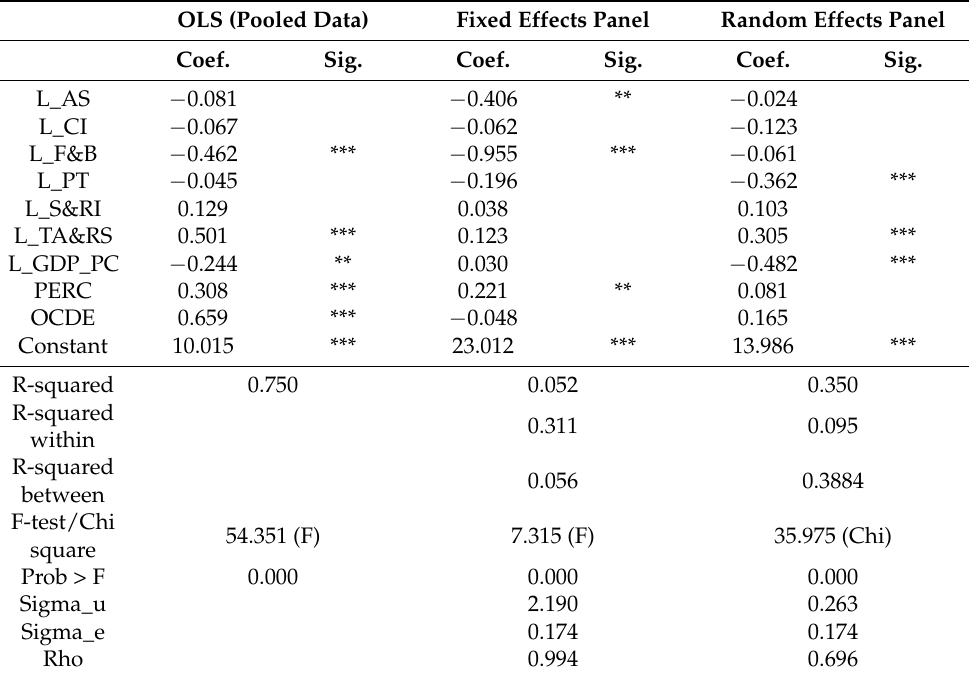
Table 2. Panel data estimations of the explanatory variables of tourism receipts (in logarithm) for the countries in the sample.